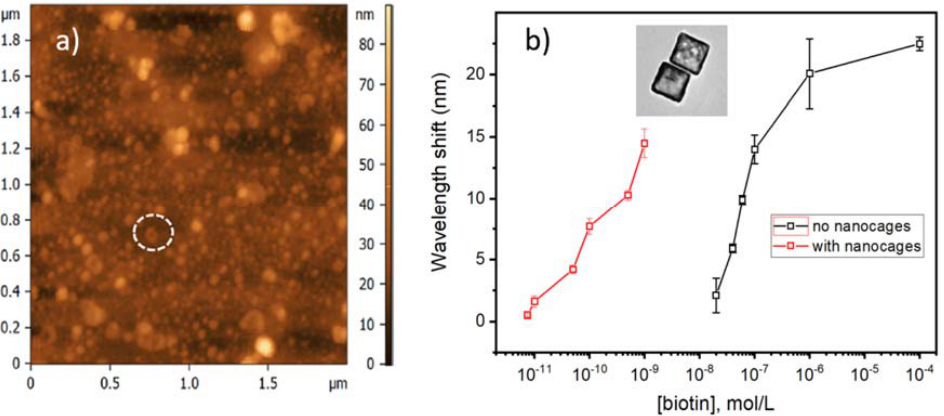
Figure 11. ( a ) AFM image of the surface of a TFBG coated with a monolayer of 10 nm thick gold nanocages; ( b ) Wavelength shifts of the most sensitive resonance of TFBGs functionalized with avidin molecules in the presence of biotin at various concentrations (adapted with permission from [9].